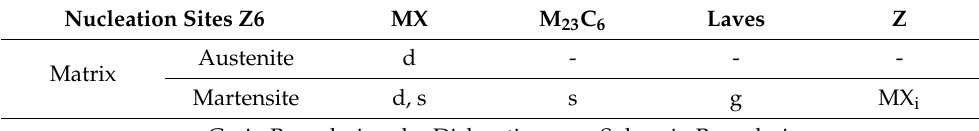
Table 3. Z6 nucleation sites for precipitate kinetic